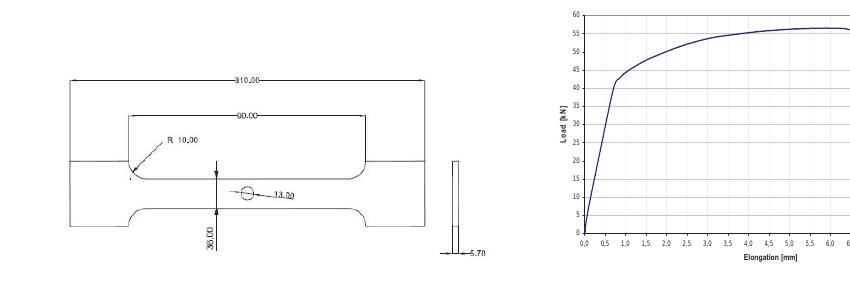
Fig. 3. D imensions (mm) of the specimens Fig. 4. Load vs elongation of the Fe 36